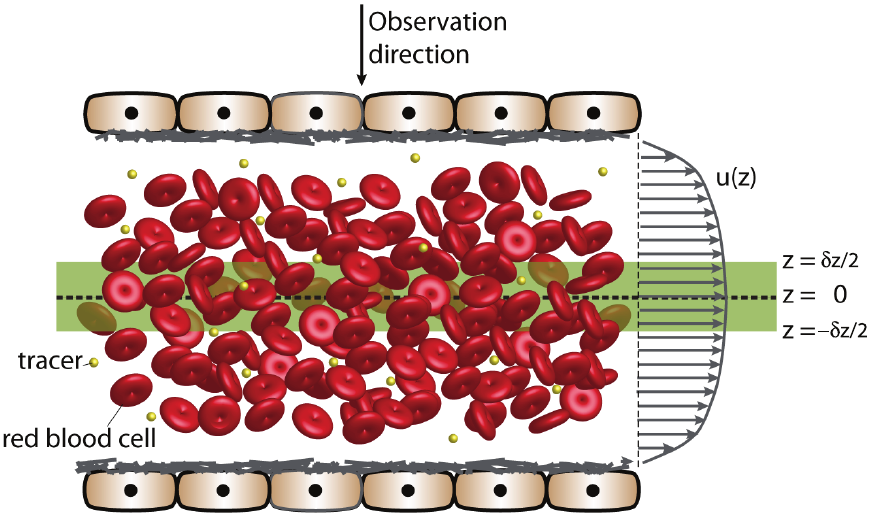
Figure 1. Blood flow and measurement volume. Schematic representation of blood flow measurement using either red blood cells or artificial tracers. The depth of the measurement volume is shown as the shaded region and is bounded by z ~{ d z = 2 and z ~ d z = 2 .